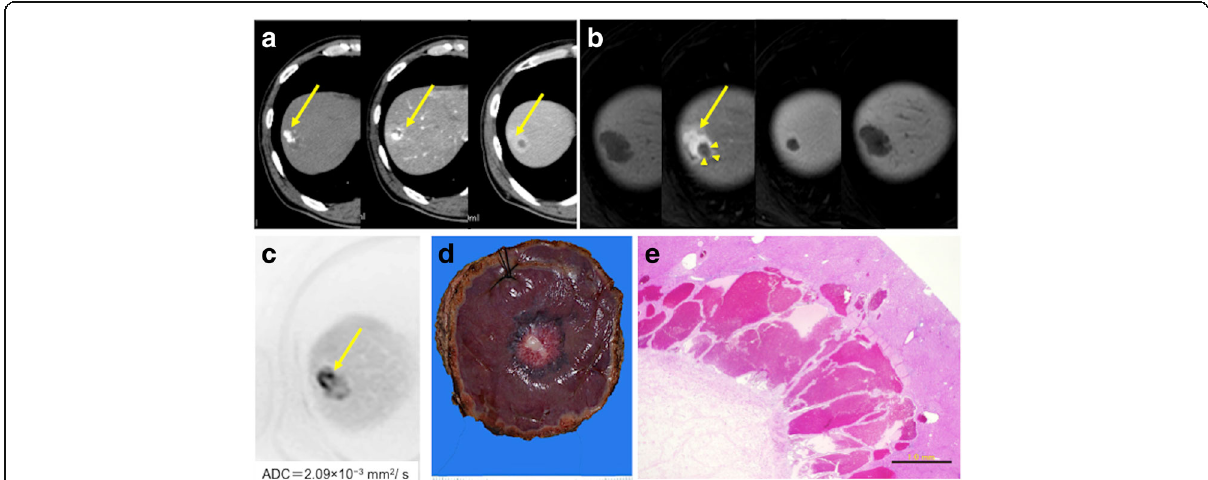
Fig. 2 The tumor was seen as a mass with peripheral nodular enhancement in the arterial phase and progressive centripetal fill-in in the portal phase of CT imaging ( a ). MRI showed that HSH was a hypointense mass on a fat-suppressed T1-weighted image and a mass with peripheral nodular enhancement in the early phase. In the late phase, the tumor was an iso-hypointense mass and filling defect in the hepatocyte phase of dynamic MRI. We considered the part with the contrast effect in CT or MRI as non-degenerative site (arrow) and the other part as degenerative site (arrow head). ( b ). The ADC mean value of the mass was 2.09×10 − 3 mm 2 /s on DW-MRI ( c ). The whitish part was shown within the hemangioma-like tumor on the liver surface and capsular retraction was identified ( d ). Histologically, there were many small vessels with fibrous replacement and hyalinization. The scale bar shows 1.0 mm ( e